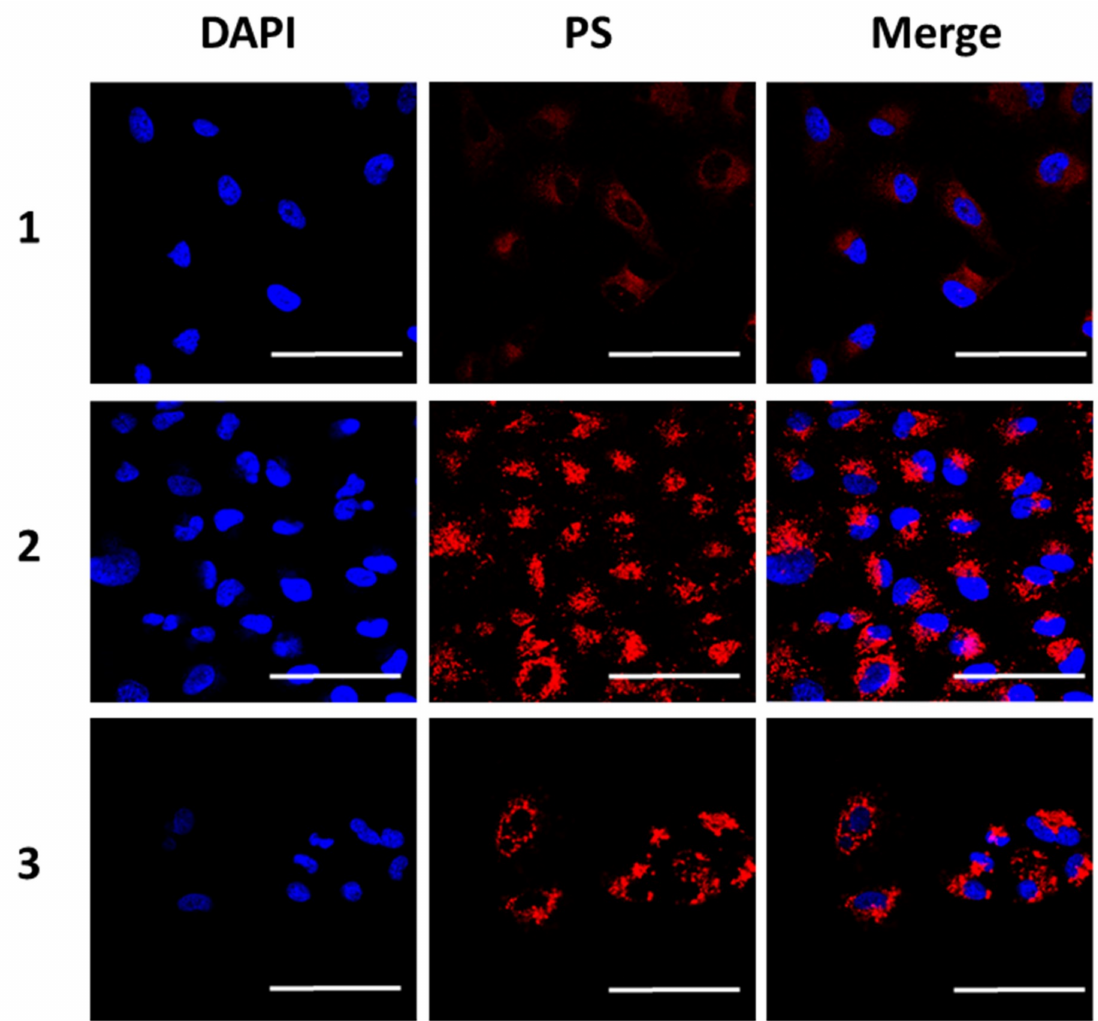
Figure 3. Uptake of 1 , 2 , and 3 by A549 cells before irradiation after 24 h incubation assessed using confocal laser scanning microscopy (CLSM). The concentration of PS was 1 µ M in each sample. 4‘,6-Diamidino-2-phenylindole (DAPI) nuclear dye (blue), PS (chlorins, red) is shown in 1 , 2 or 3 and in merged images. Bars, 100 µ